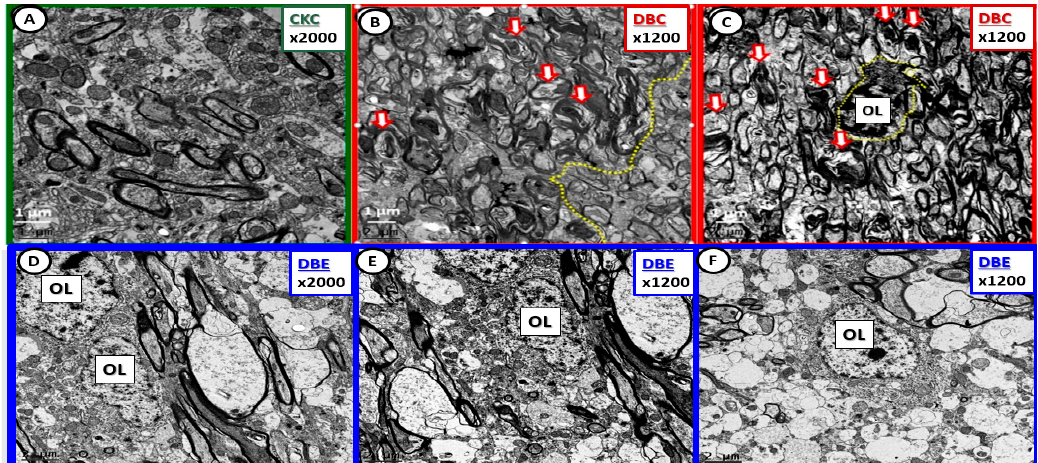
Figure 8. Diabetes-induced myelin disarray in the transitional zone was protected by empagliflozin treatment. Panel ( A ) illustrates the findings in the CKC. Panels ( B ) and ( C ) depict the marked myelin disarray, and note the more normal appearing myelin in panel ( B ) with the demarcation line (yellow dashed line) between more normal myelin and the myelin disarray. Also note the open arrows in panels ( B ) and ( C ), which depict axonal collapse within the myelinated axons. Panel ( C ) demonstrates an oligodendrocyte (OL) with increased chromatin condensation. In contrast note how treatment with empagliflozin results in less myelin disarray and illustrates normal oligodendrocyte morphology without chromatin condensation within the nucleus. Magnification 2000 × in panels ( A ) and ( D ) with scale bar =1 µ m. Magnification 1200 × ; scale bar = 1–2 µ m (panels ( B ), ( C ), ( E ), ( F